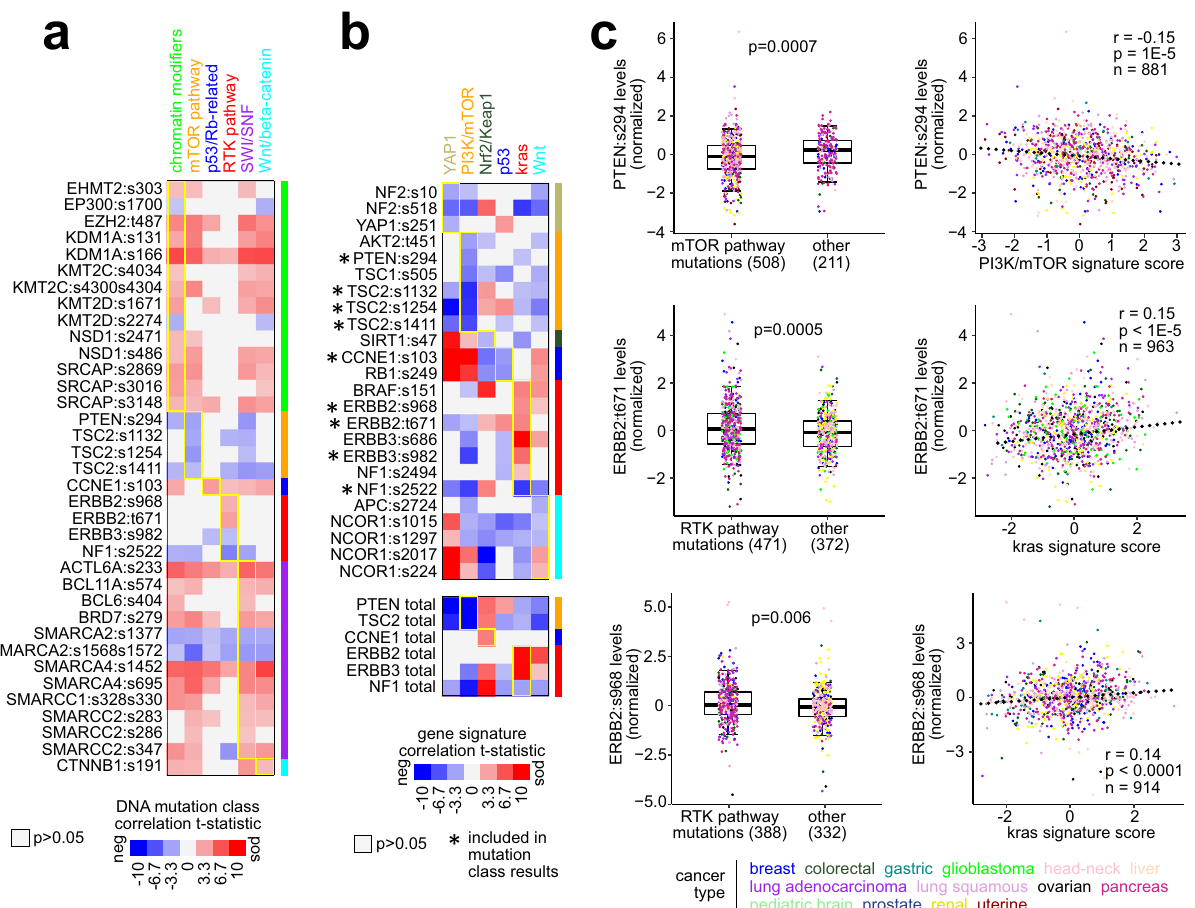
Fig. 9 Phospho-proteins associated with pathway alteration. a For 106 phospho-proteins (with data for >50% of samples for seven or more cancer types) with genes involved in curated pathway sets 23,25,57,68 , the Pearson correlation with each pathway-level DNA mutation class from Fig. 7a was computed. Shown are 36 of the 106 phospho-proteins for which a signi fi cant association ( p < 0.05) with its corresponding pathway mutation class was found. b For the 106 phospho - proteins, the Pearson correlation with each pathway gene signature from Fig. 7b was computed. Shown are 24 phospho- proteins for which a signi fi cant association ( p < 0.05) with its corresponding pathway signature was found. Nine phospho-proteins are shared between a and b results. c For selected phospho-proteins PTEN:s294, ERBB2:t671, and ERBB2:s968, associations with mTOR pathway or RTK pathway mutation class (left) and association with mTOR pathway or RTK pathway signature (right) is represented. p values by t -test (box plots) or Pearson correlation (scatter plots). Box plots represent 5% (lower whisker), 25% (lower box), 50% (median), 75% (upper box), and 95% (upper whisker). n = biologically independent